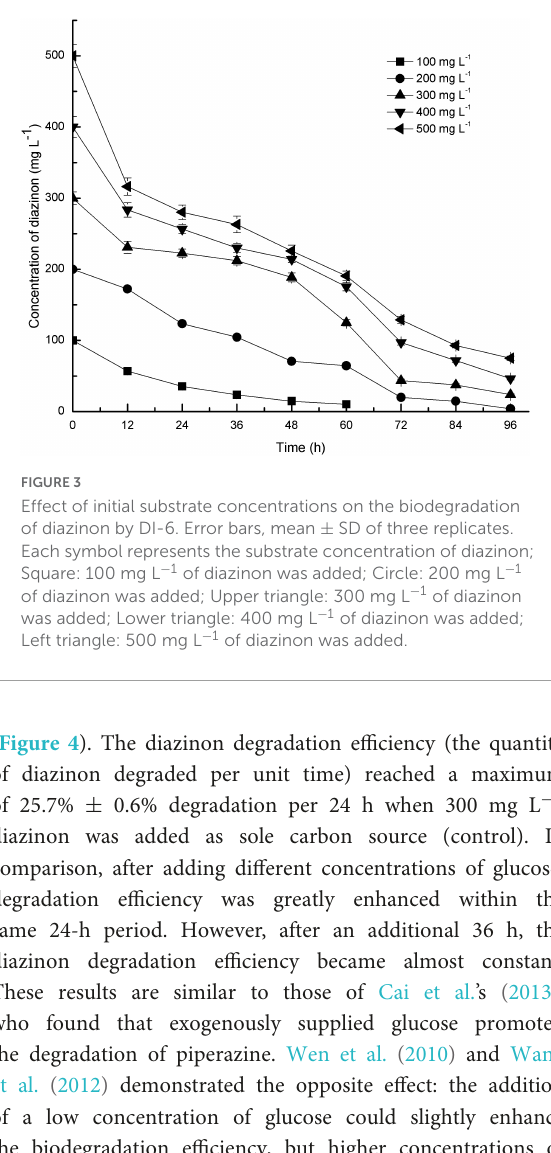
( Figure 4 ). The diazinon degradation efficiency (the